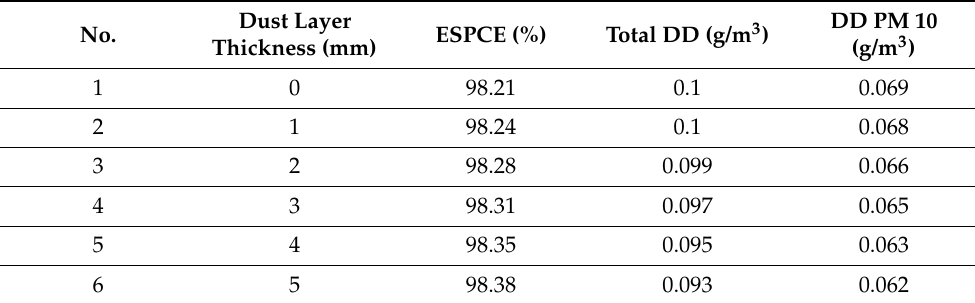
Table 10. The dust resistivity is 10 12 Ω × cm, when the thickness of the dust layers on the collecting surfaces is the same and the sections are constantly